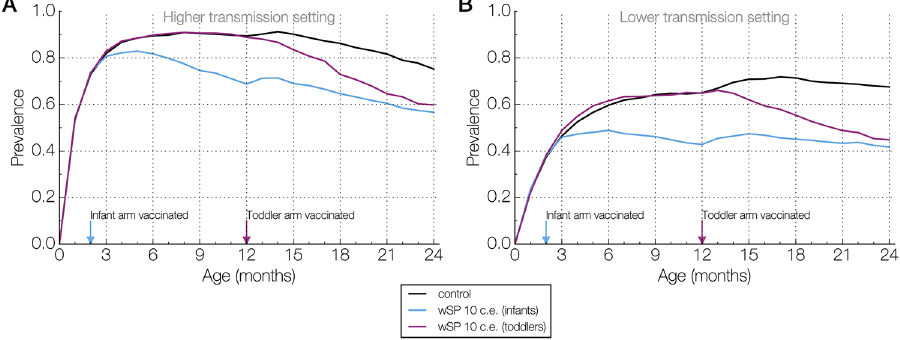
Fig 1. Age-specific carriage prevalences from representative simulation runs. (A) Carriage prevalences, sampled every month starting from birth, is shown for three arms–control (black), those vaccinated as infants (blue), and those vaccinated as toddlers (purple)–in a simulated trial in the higher transmission setting. Only the 10 colonization equivalent (c.e.) wSP vaccine efficacy is presented here. On the x-axis, two arrows indicate the age at which the vaccine was administered for the vaccinated arms. (B) Similar to (A), but for a simulated trial in the lower transmission setting.